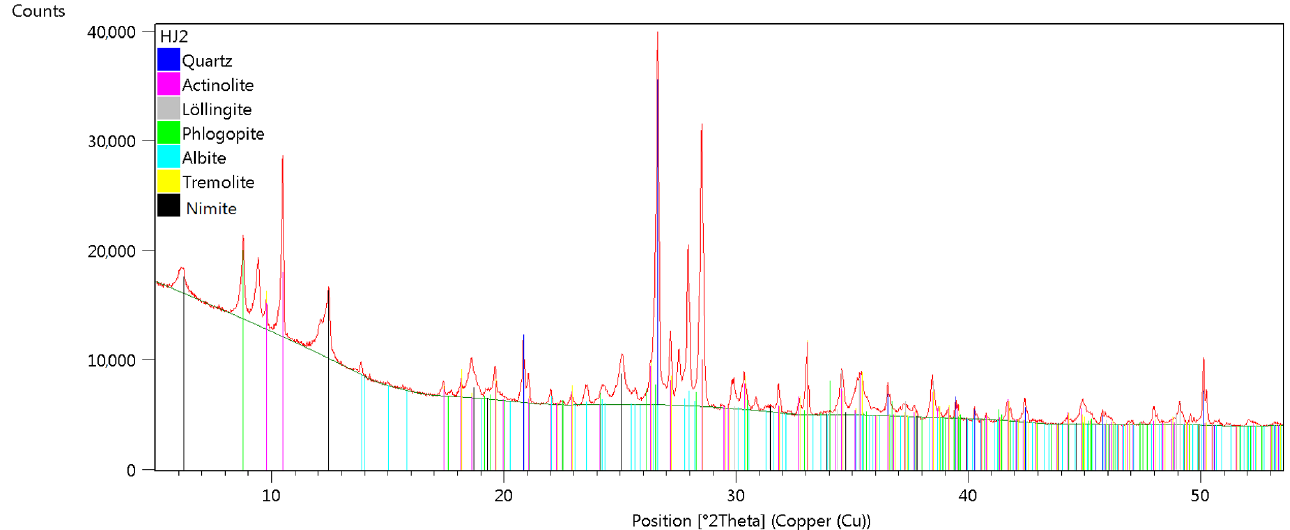
Figure 2. The XRD pattern of the arsenic waste.